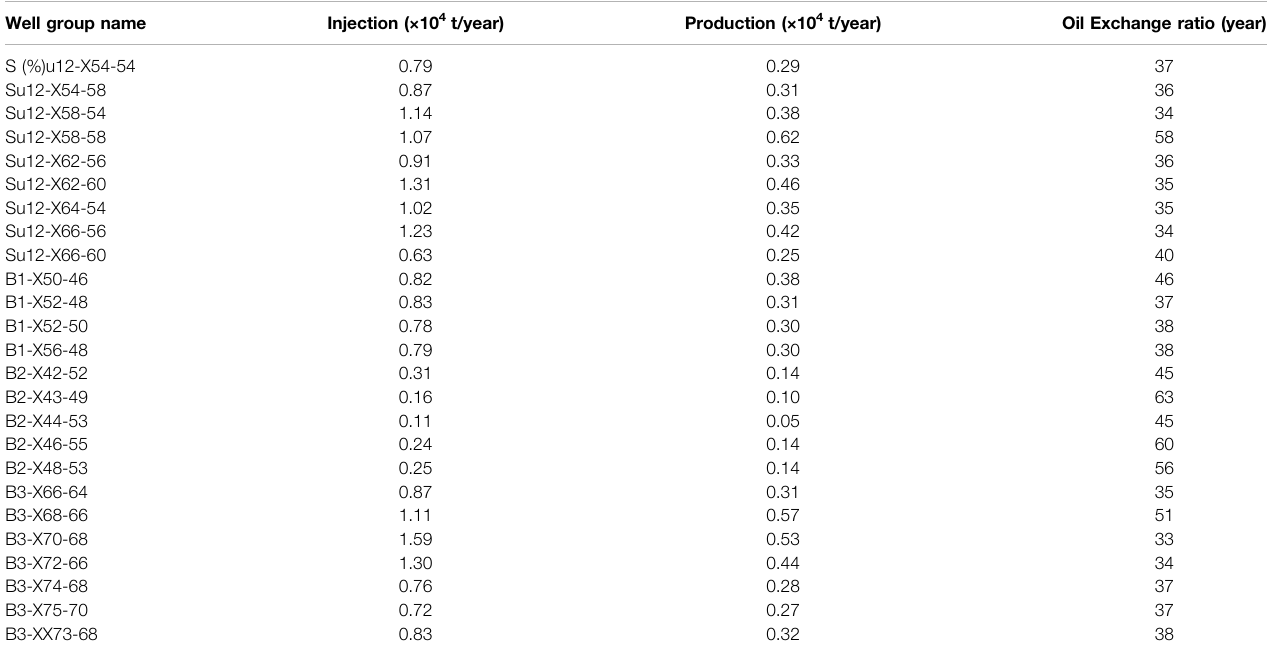
TABLE 8 | Daqing Oil fi eld well group production data. Well group